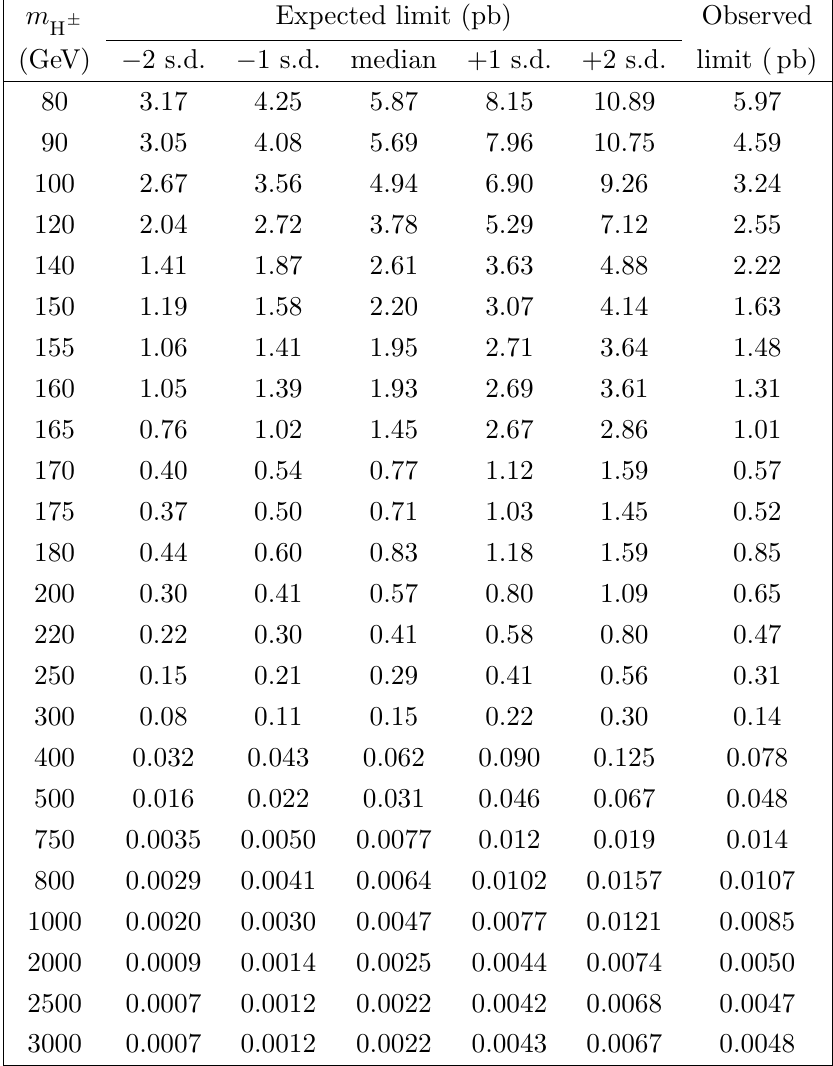
Table 4 . The expected and observed 95% CL exclusion limits on (cid:27) mass range from 80 GeV to 3 TeV. The from the expected